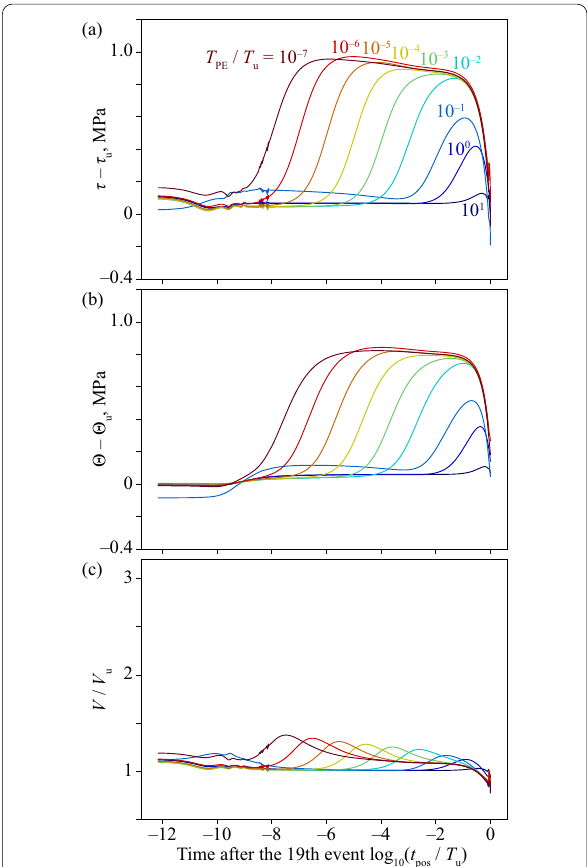
Fig. 10 Effect of PE at x = 0.5 (cid:31) x sl with the slip law and various fluid mobility as a function of the time after the 19th earthquake. Poroelastic diffusion time T u = R 2 / c is indicated by color as shown in a . a Shear stress, b shear strength, and c Slip rate relative to the undrained